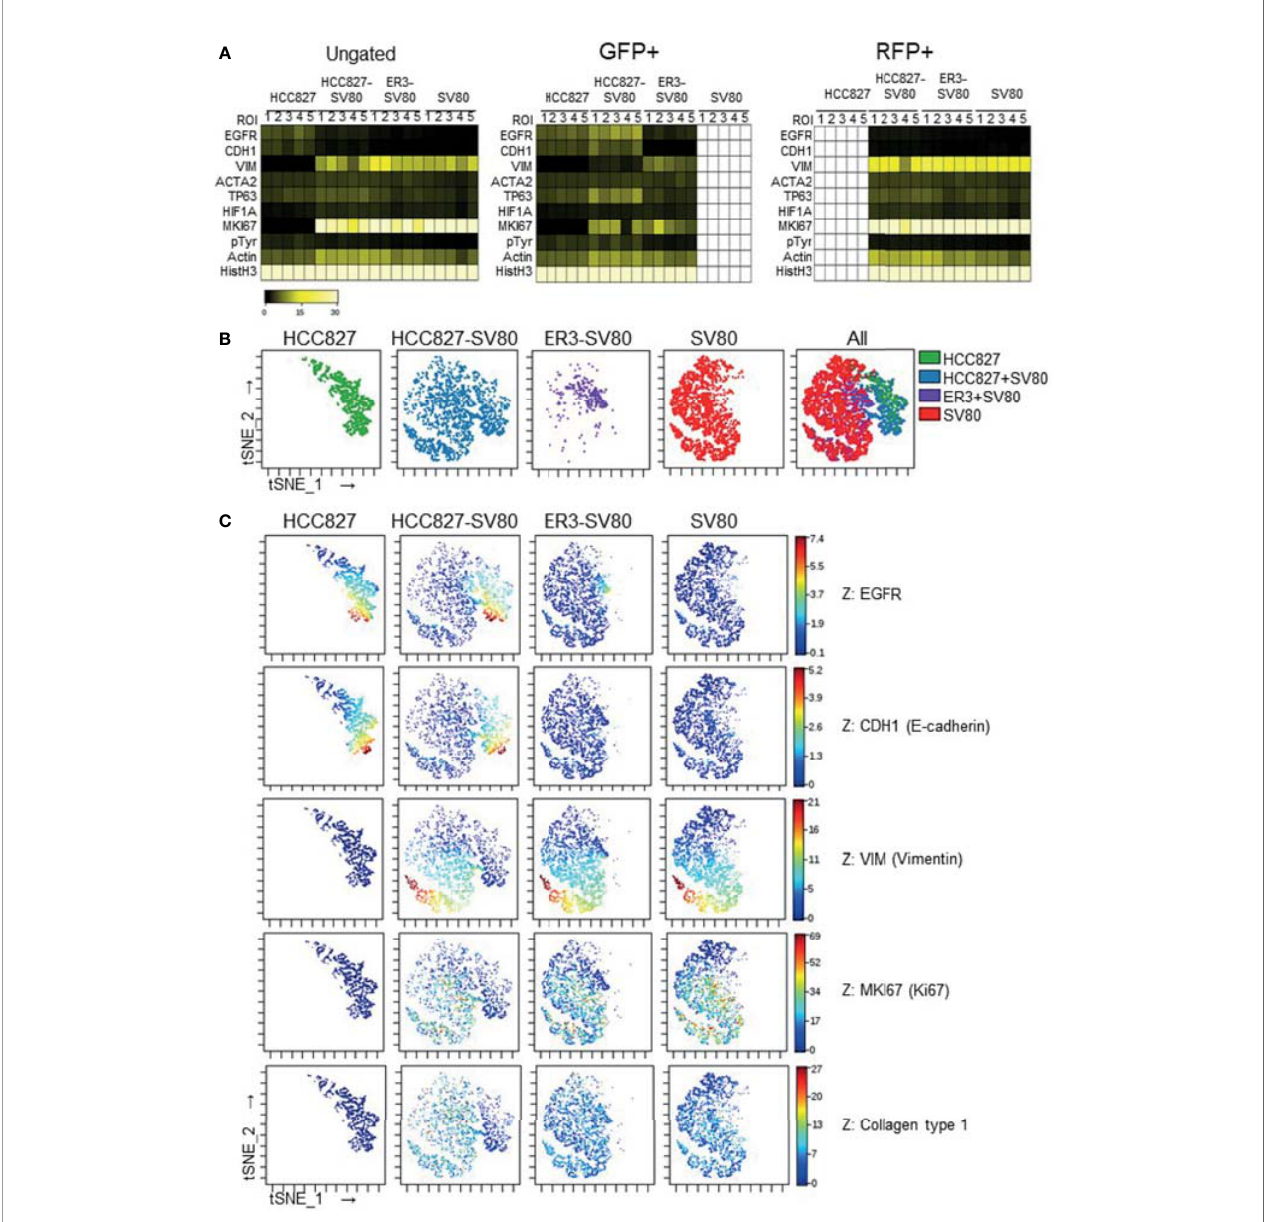
FIGURE 7 | In-depth analysis of imaging mass cytometry single-cell data from mono- and co-culture spheroids. (A) Single-cell expression data obtained from segmentation of the imaging mass cytometry experiment are displayed as a heatmap of the ungated (left), GFP+ (middle) and RFP+ (right) populations. Single-cell data was fi rst generated as the mean pixel intensity for each cell, and the median intensity of all cells within a given population is displayed in the heatmaps. (B) The tSNE algorithm was applied on the ungated population based upon expression of the three markers EGFR, CDH1 (E-cadherin), and VIM (vimentin). viSNE plots displaying the distribution of cells from the different samples. (C) Marker expression of EGFR, CDH1 (E-cadherin), VIM (vimentin), MKI67 (Ki67), and Collagen type 1 displayed on the viSNE spheroids with a prominent self-sorting upon erlotinib-treatment as the very few surviving GFP+ (HCC827 cells) are detected in a protective location towards the middle of the spheroid (high distance-to-border value) and the average distance-to-border of ( Figure 9G ), GFP+ ( Figure 9H ) and RFP+ ( Figure 9I ) the RFP+ (SV80) cells decreased as the fi broblast composition populations within the HCC827+SV80 and ER3+SV80 spheroids changed from centrally localized to diffuse and dominant. The treated with erlotinib or vehicle (DMSO) control. These violin plots tSNE algorithm was again applied on the ungated population. clearly demonstrate the re-organization of the HCC827-SV80